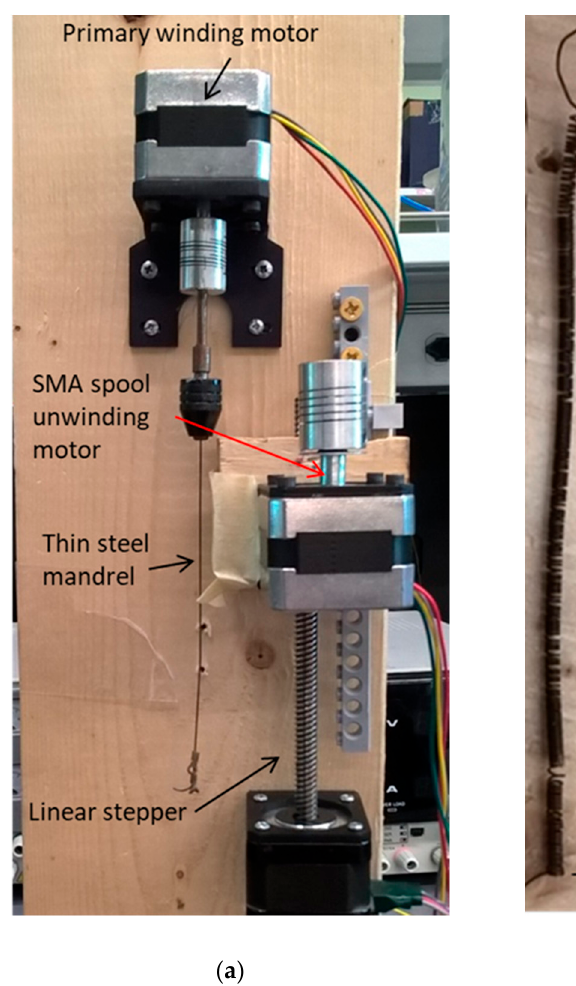
Figure 4. Muscle fabrication ( a ) custom coiled SMA fabrication setup; ( b ) annealed muscle (50 mm) and ( c ) muscle cut into two 25-mm halves and crimped. The two rotary motors are Adafruit NEMA-17 0.35 A 12 V Stepper motors, while the linear stepper is a Moons HD4001–20N Stepping Motor. The motors are controlled by an Arduino Uno microcontroller and two stacked Adafruit motor shields (V2). The motor shields are connected to a Topward 6306D power supply, with 12 V, 0.7 A for the two Adafruit motors and 0.25 A, 9 V for the Moons stepper. The Arduino has code written to synchronize the rotations of the motor such that the mandrel and spool have equal tangential velocities.